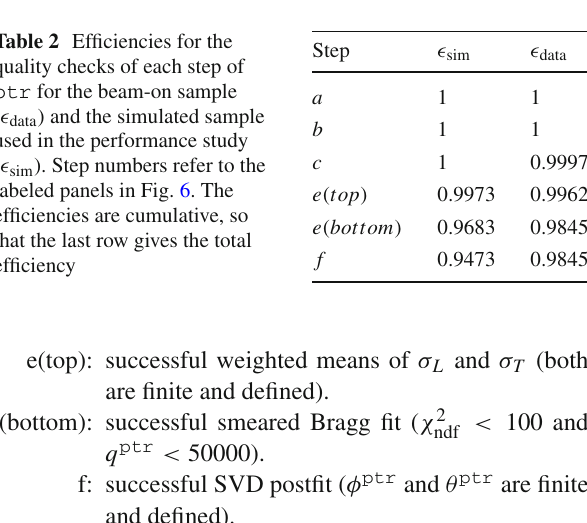
Fig. 14 Head-tail efficiency contours for HCF (left) and ptr (right) in the inclination ( | θ truth − 90 ◦ | ) vs. energy ( E truth ) plane. The solid contours are spaced every 2%. The red and lavender lines demarcate regions with head-tail efficiencies over 0 . 7 and 0 . 9, respectively